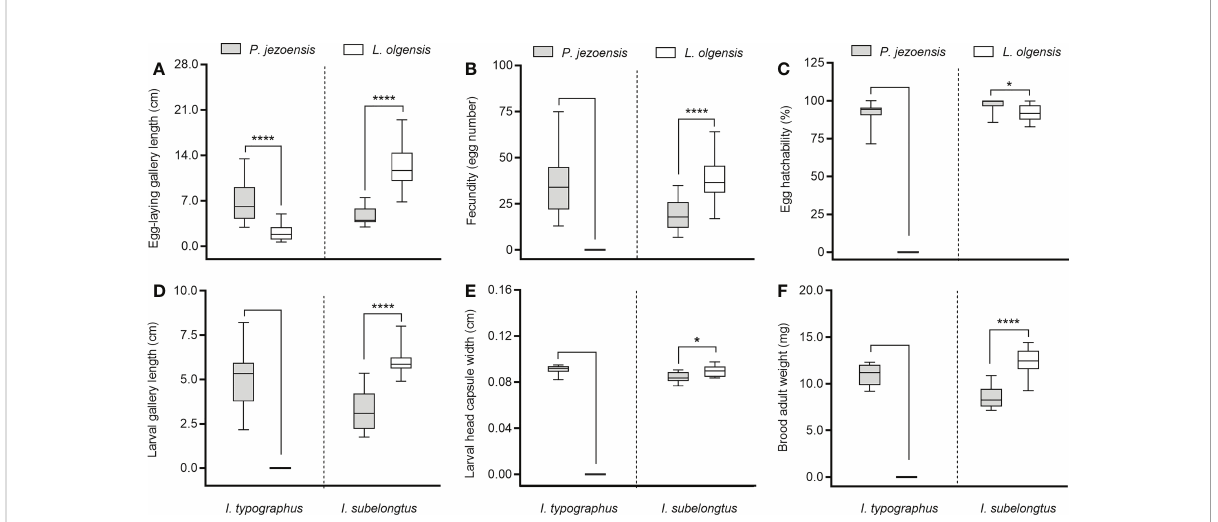
FIGURE 1 Minimum to maximum developmental indices of I typographus and I subelongatus in response to stem inoculation. (A) Egg-laying gallery length of female; (B) female fecundity (number of eggs); (C) egg hatchability (%); (D) larval gallery length; (E) larval head capsule width; (F) brood adult weight. Asterisks indicate signi fi cant differences (* p < 0.05, **** p < 0.0001; T-test for independent samples, a